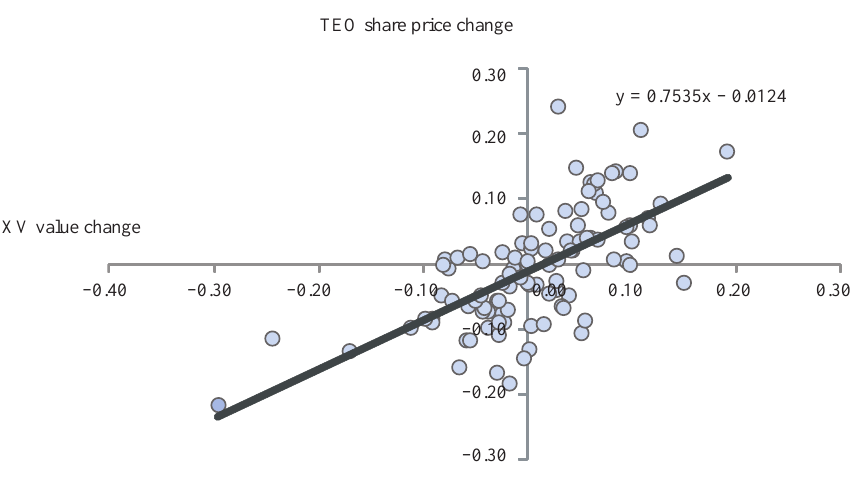
Fig. 2. Finding historical beta using a linear